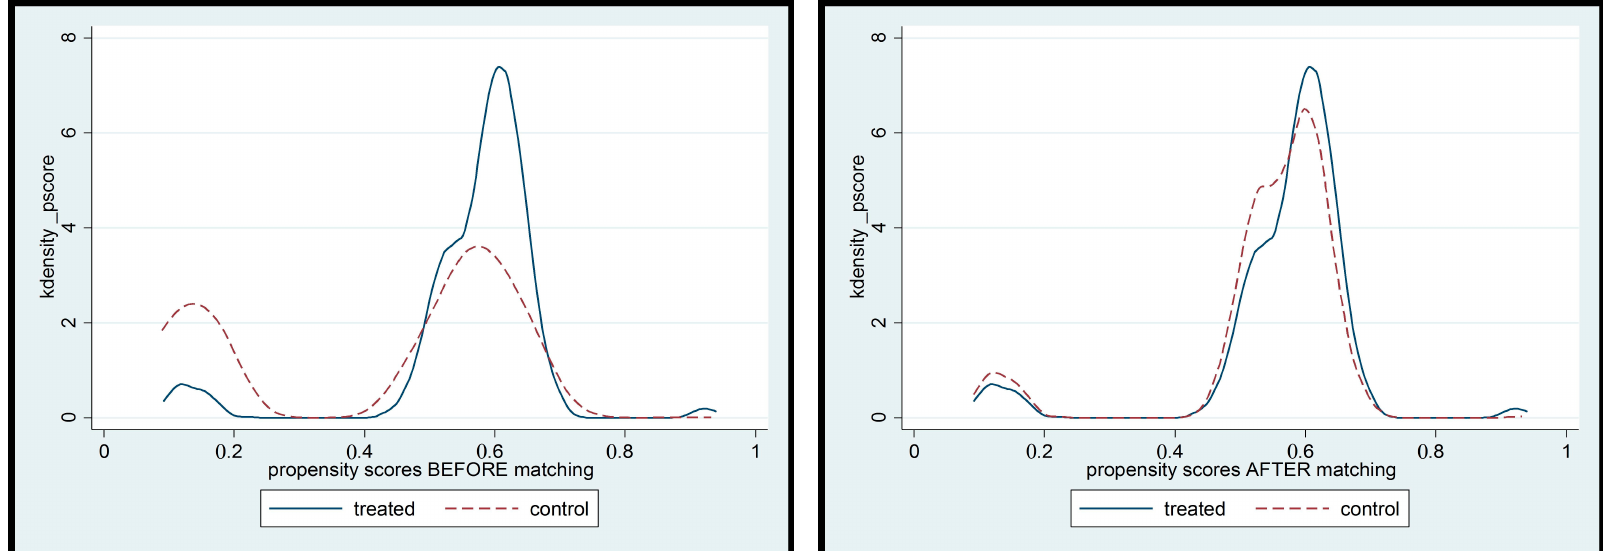
Figure 3. Assessing the adequacy of the matching approach. Table 2. Summary statistics of the matching variables and estimates of logit regression models for stage 1 of propensity score matching.